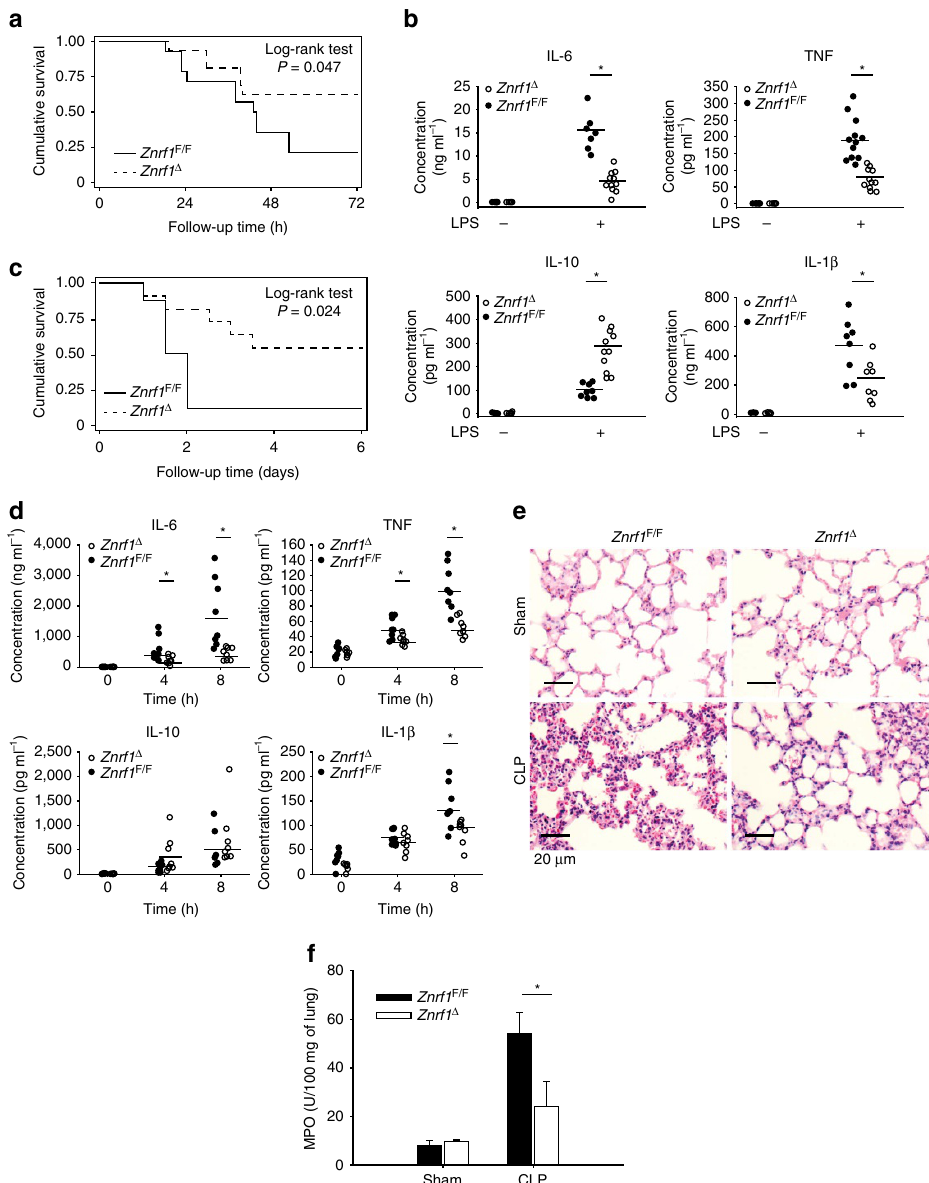
Figure 2 | Znrf1 D mice are more resistant to LPS- and CLP-induced sepsis. ( a ) Survival of Znrf1 D (dotted line, n ¼ 11) and Znrf1 F/F mice (solid line, n ¼ 11) injected intraperitoneally with LPS (15mgkg (cid:2) 1 of body weight). ( b ) ELISA analysis of the indicated cytokines in sera from Znrf1 D and Znrf1 F/F mice 6h after LPS challenge. ( c ) Survival of Znrf1 D mice (dotted line, n ¼ 8) and Znrf1 F/F mice (solid line, n ¼ 8) after CLP challenge. ( d ) ELISA analysis of the indicated cytokines in sera from Znrf1 D and Znrf1 F/F mice collected 0, 4 and 8h after the CLP procedure. ( e ) Haematoxylin and eosin staining of histological sections of lung tissues collected from Znrf1 D and Znrf1 F/F mice (lower panel) 8h after CLP and from sham-operated control mice (upper panel). Objective magnification, (cid:3) 20. Scale bar, 20 m m. ( f ) The MPO activity in lung tissues from Znrf1 D and Znrf1 F/F mice 8h after CLP. * P o 0.05 (Student’s t -test). (Error bars,